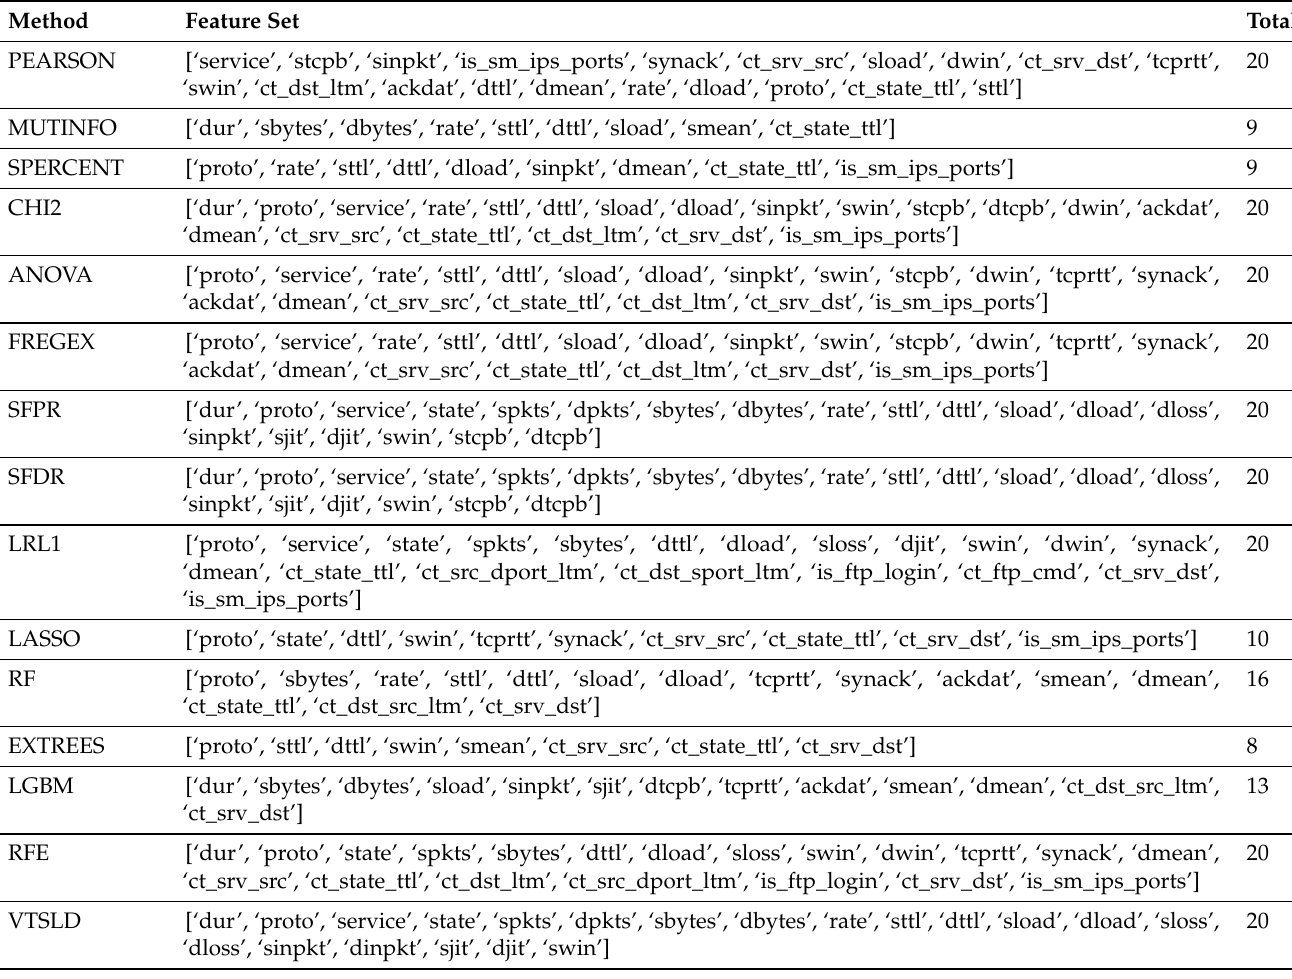
Table 5. Selected features by individual FS method.